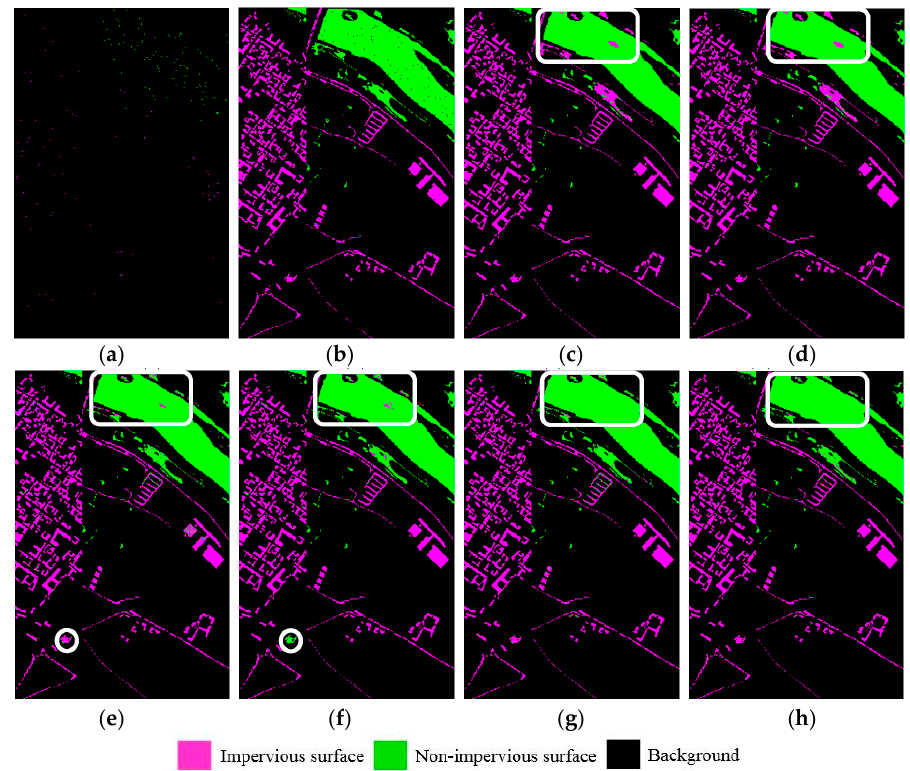
Figure 8. Pavia center image: ( a ) training data; and ( b ) test data. Estimation maps obtained by: ( c ) SPE-SVM; ( d ) SS-SVM; ( e ) SPE-RF; ( f ) SS-RF; ( g ) SPE-SR; and ( h ) SS-SR.